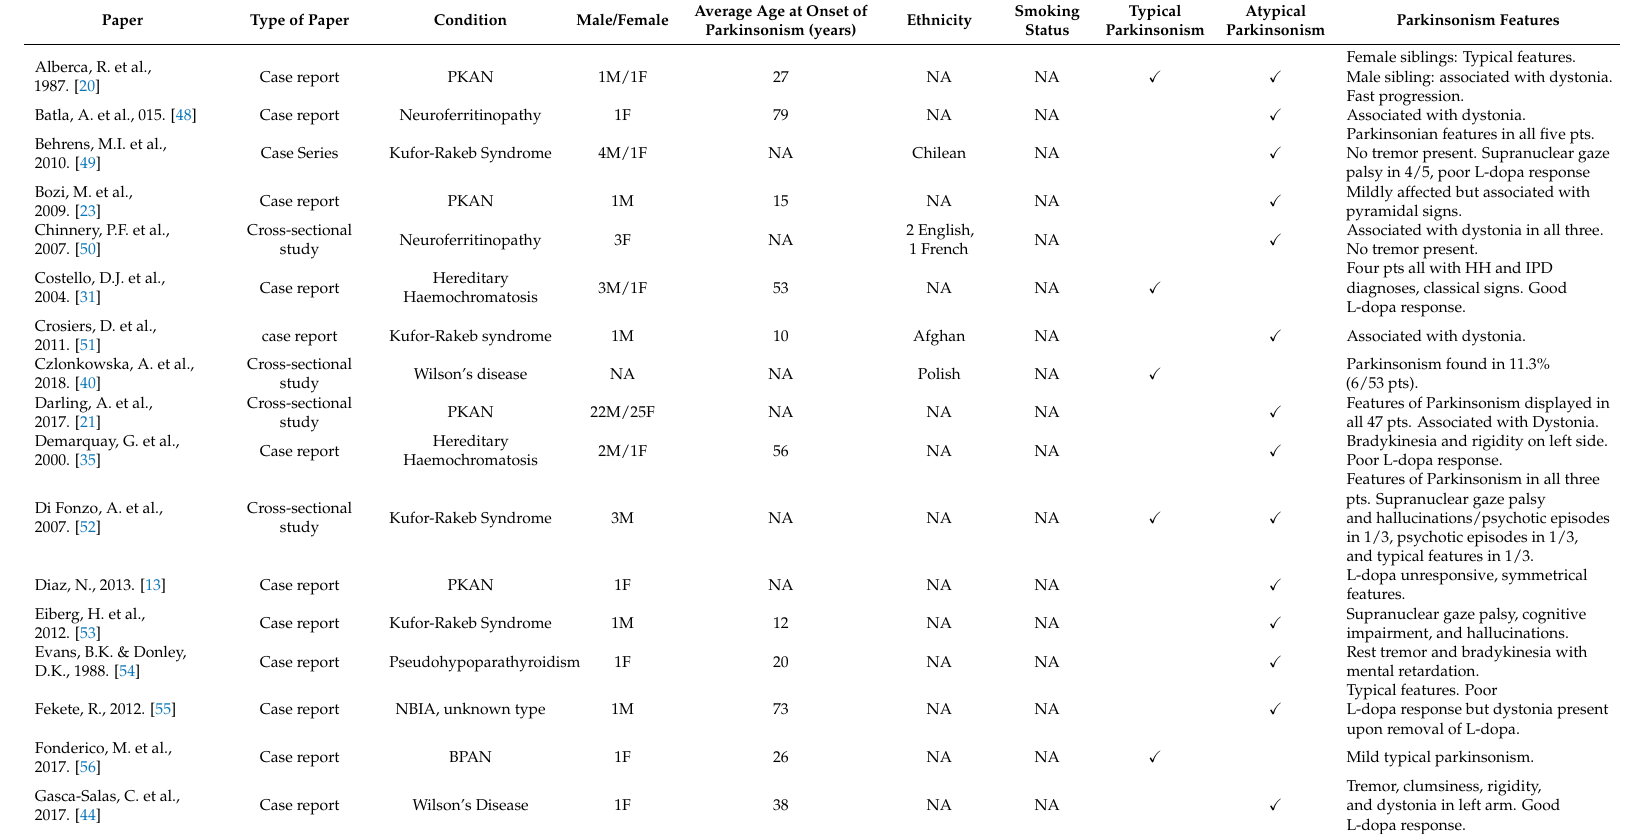
Table A1. Table showing the individual breakdown of the included publications. NA = Not Available.